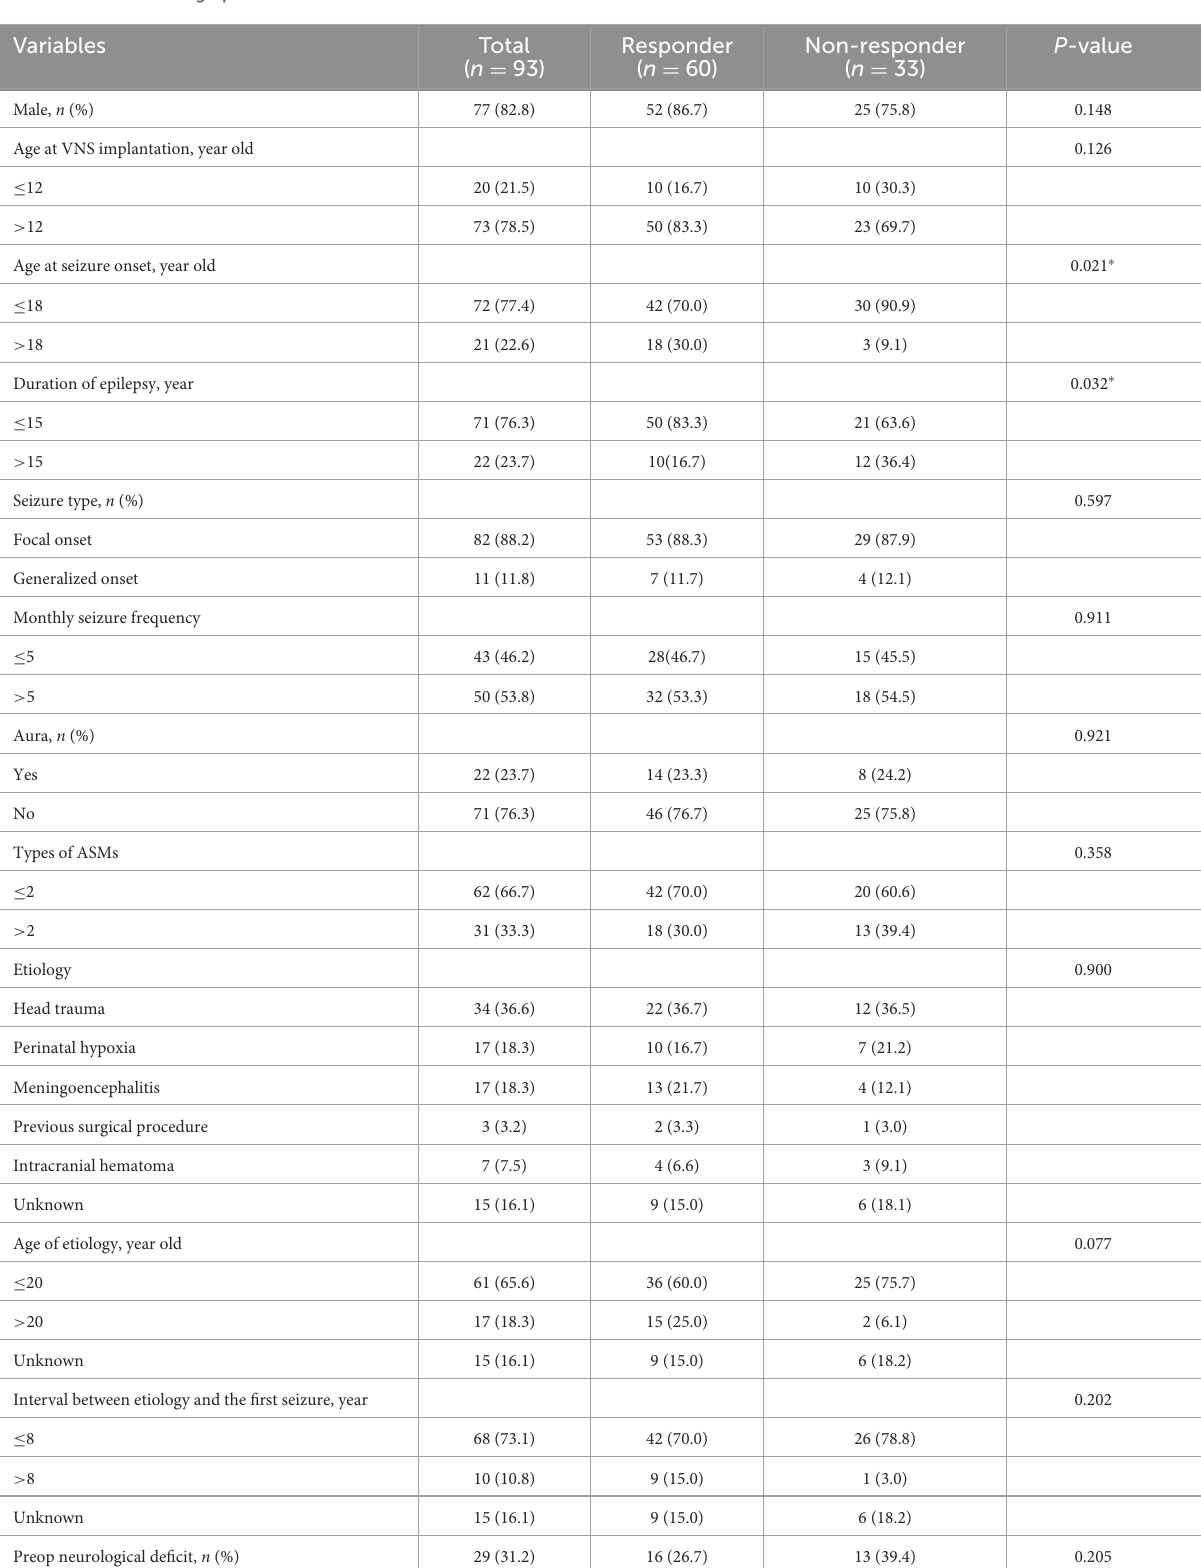
TABLE 1 Patients’ demographic and clinical